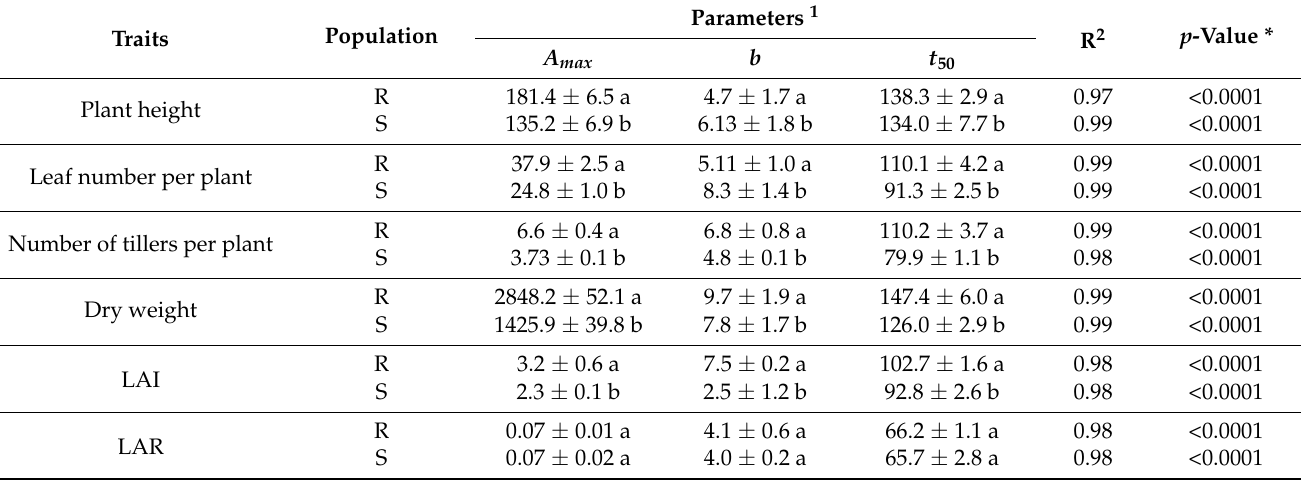
Table 1. Parameters of the three-parameter sigmoid model for plant height, leaf number, number of tillers, dry weight, leaf area index (LAI), and leaf area ratio (LAR) in resistant (R) and susceptible (S) sub-populations of P. brachystachys to the ACCase-inhibiting